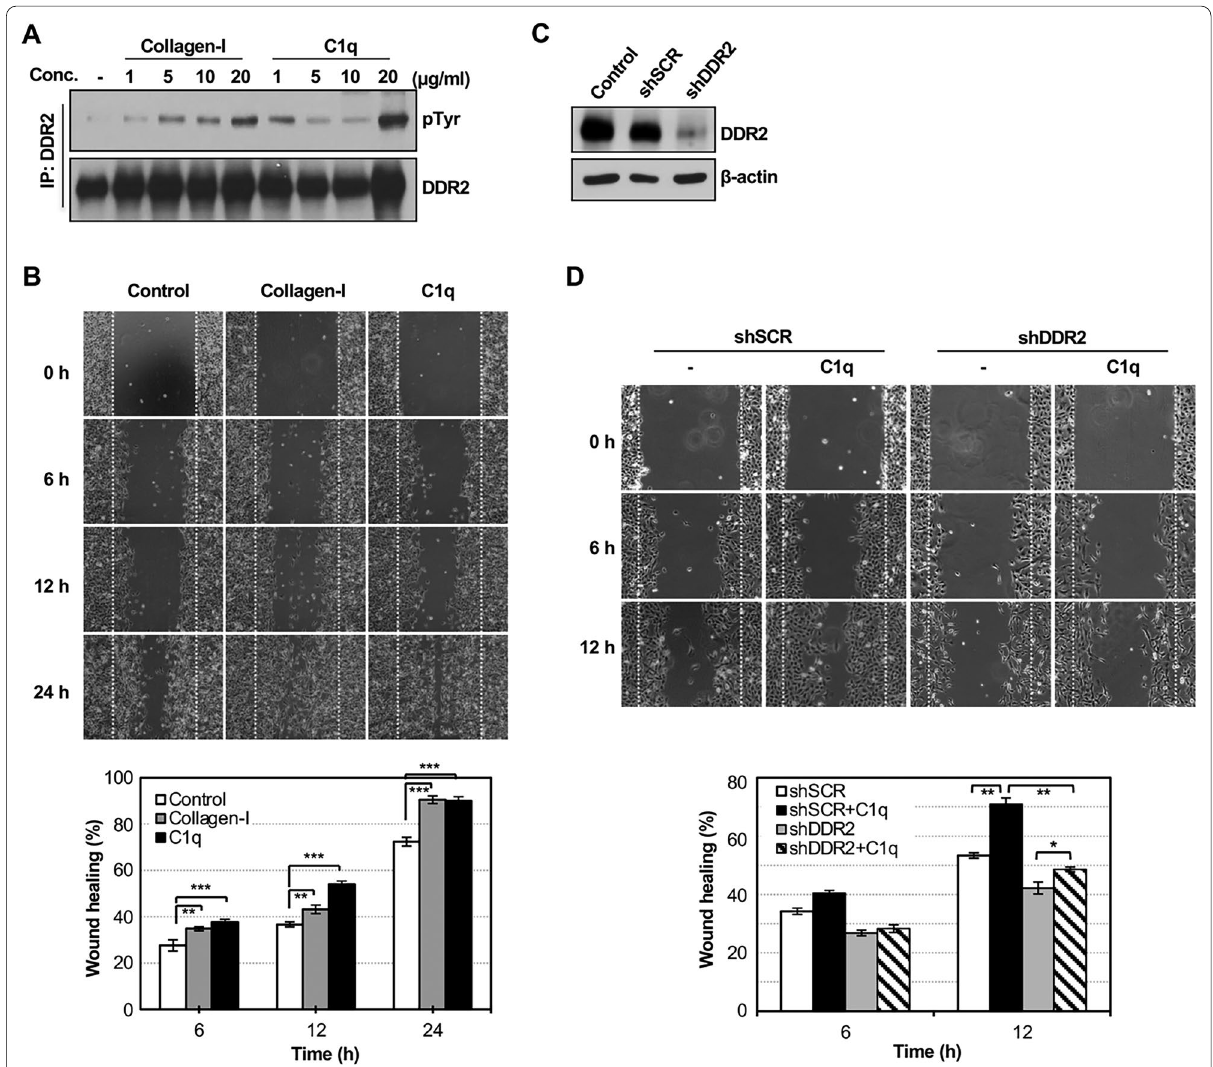
Fig. 3 C1q‑DDR2 binding promotes wound healing. A DDR2 phosphorylation was evaluated by immunoprecipitation with rabbit anti‑DDR2 Ab and western blot with anti‑phosphotyrosine Ab (4G10) or mouse anti‑DDR2 Abs. HT1080 cells were incubated with the indicated concentration of collagen‑I or C1q for 24 h. One representative image of three independent experiments. B HT1080 cells were grown to confluence in 12‑well plates; a straight scratch was made and then treated with 20 μg/mL C1q for the indicated time. The wound areas were calculated and expressed as the percentage of wound closure to the initial wound areas. Values are presented as the means SEM of three independent experiments. C ± Western blot of DDR2 knockdown in HT1080 cells. D The wound healing assay was performed as described in 3B after transfection of DDR2 shRNA or scrambled control RNA (shSCR). Values are presented as the means SEM of three independent experiments. * p < 0.05, ** p < 0.01, *** p < 0.001 ± (one‑way